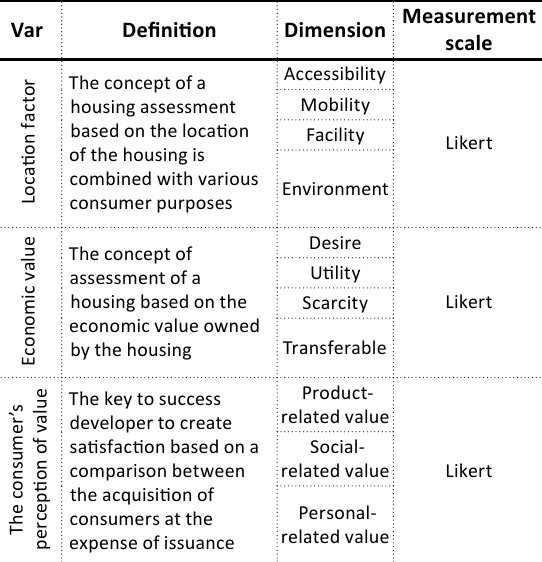
Table 1. Operational